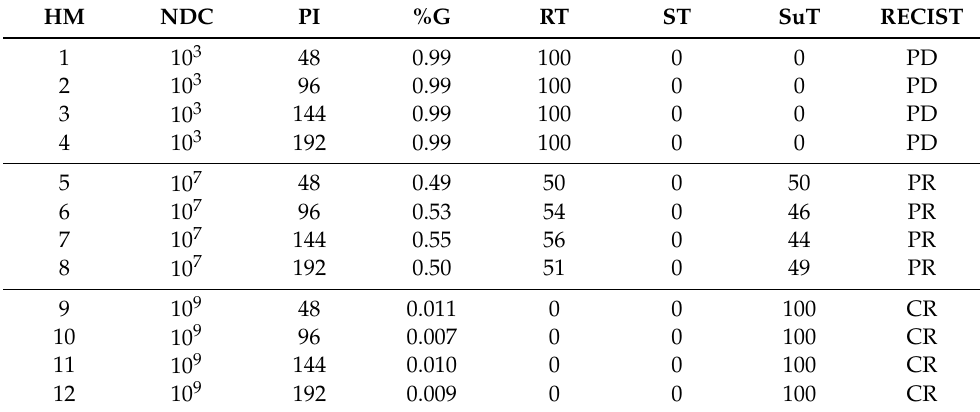
Table 2. Hypothetical immunotherapy for ODEs model with different number of Dendritic cells (DCs) injected and different periods of infusion.